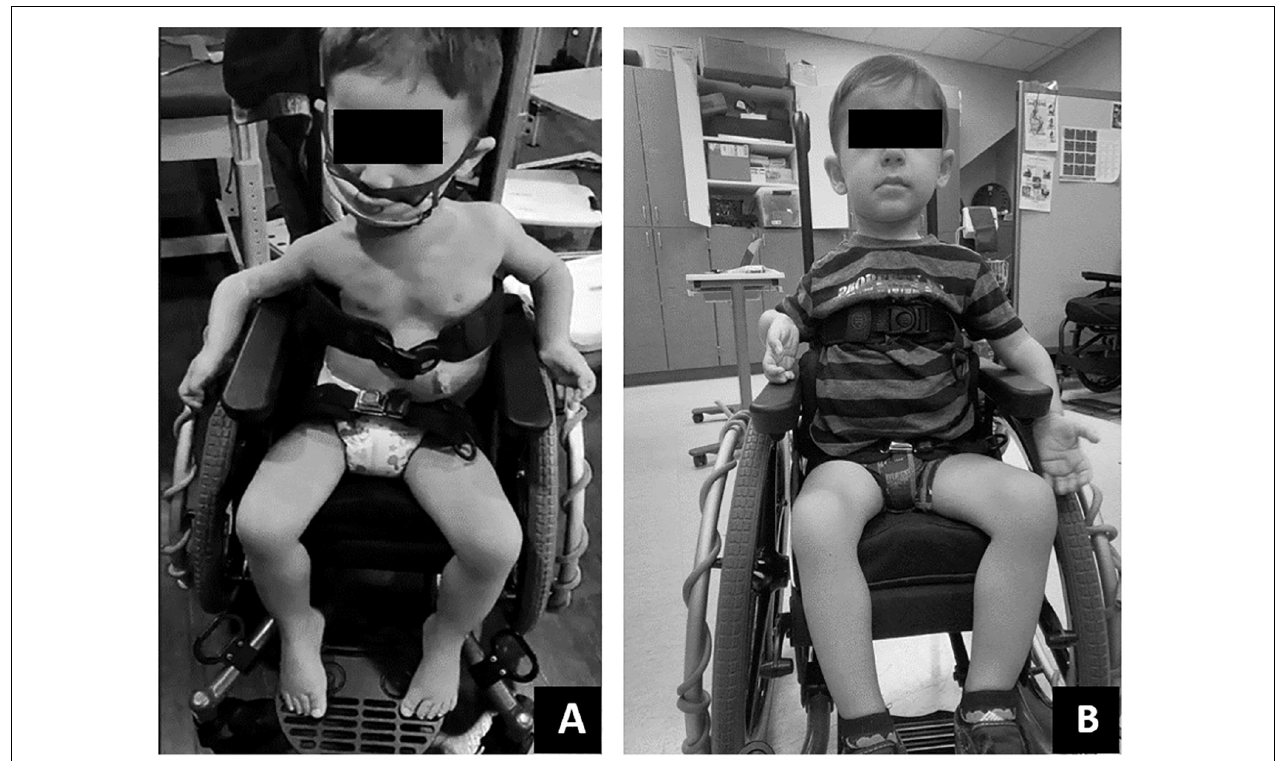
FIGURE 5 | (A) Initially this child demonstrated poor postural positioning while in his manual wheelchair including lack of contact with foot plate, sacral sitting, hip abduction, lateral collapse at the trunk and laterally tilted head position. (B) With gains in postural control at the trunk and pelvis and minor modifications to